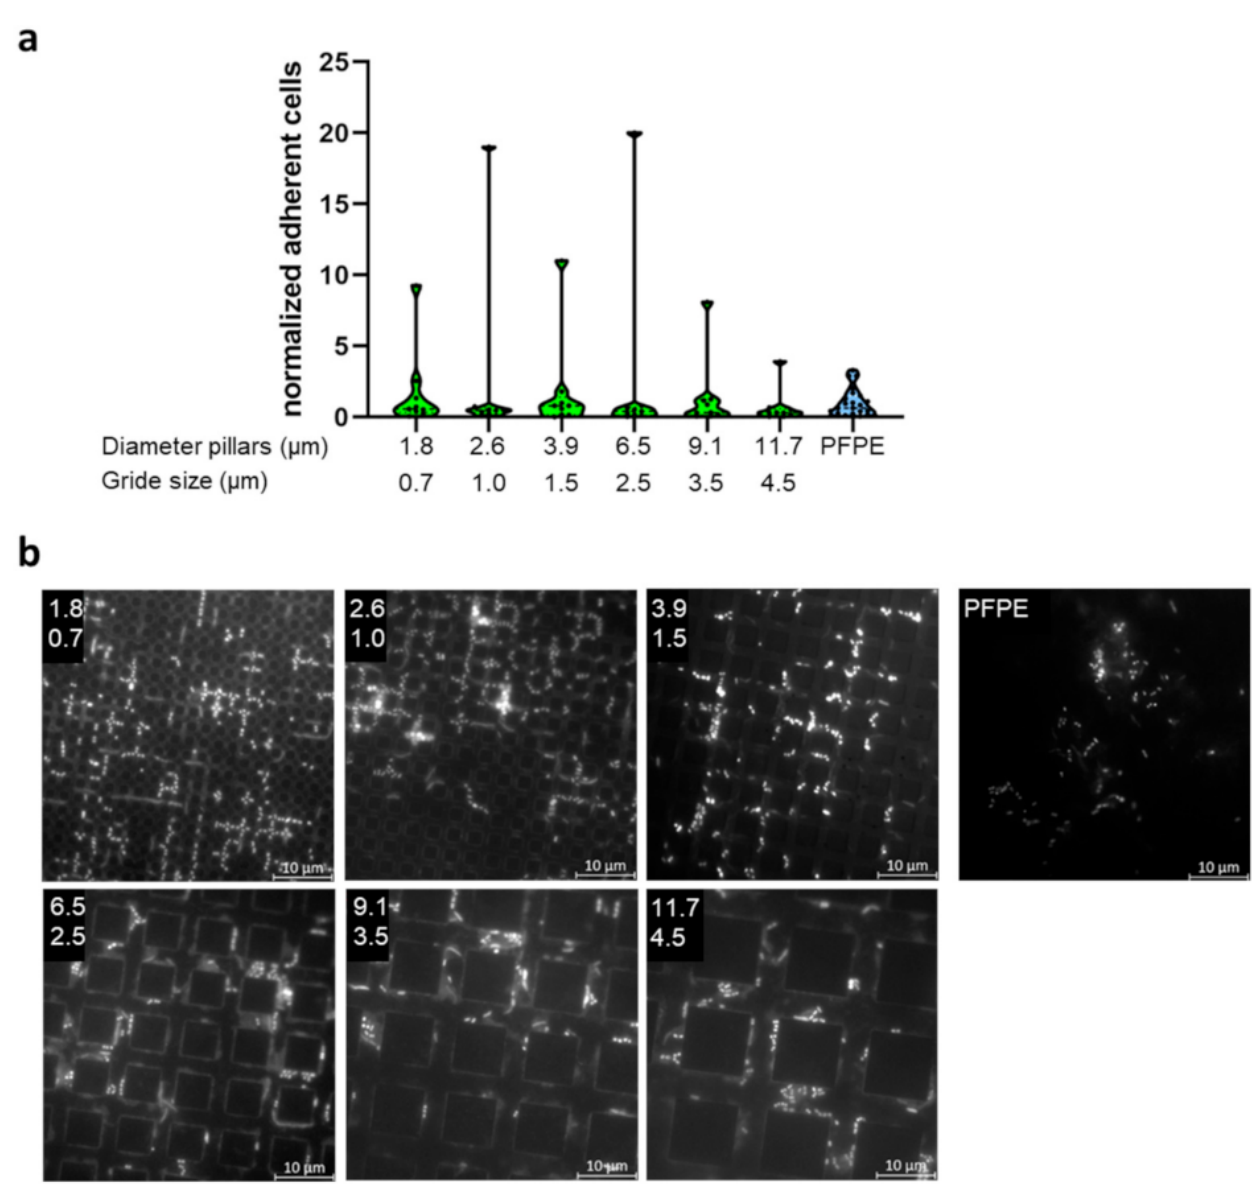
Figure 5. Adherence of microorganisms to specimens with pillar structures of different dimen- sions. ( a ) Specimens made from PFPE containing pillars of different dimensions were exposed to the oral cavity for 8 h. Here, only selected dimensions are shown, with the full dataset avail- able in Supplementary Figures S5 and S8. Depicted is the number of adherent cells normalized to the adherence on plain PFPE. ( b ) Representative images of DAPI-stained specimens for the ana- lyzed dimensions. The upper number indicates the diameter of the pillars in µ m and the lower number the grid size in µ m. Microorganisms are mostly detected within the crevities between the pillar-like